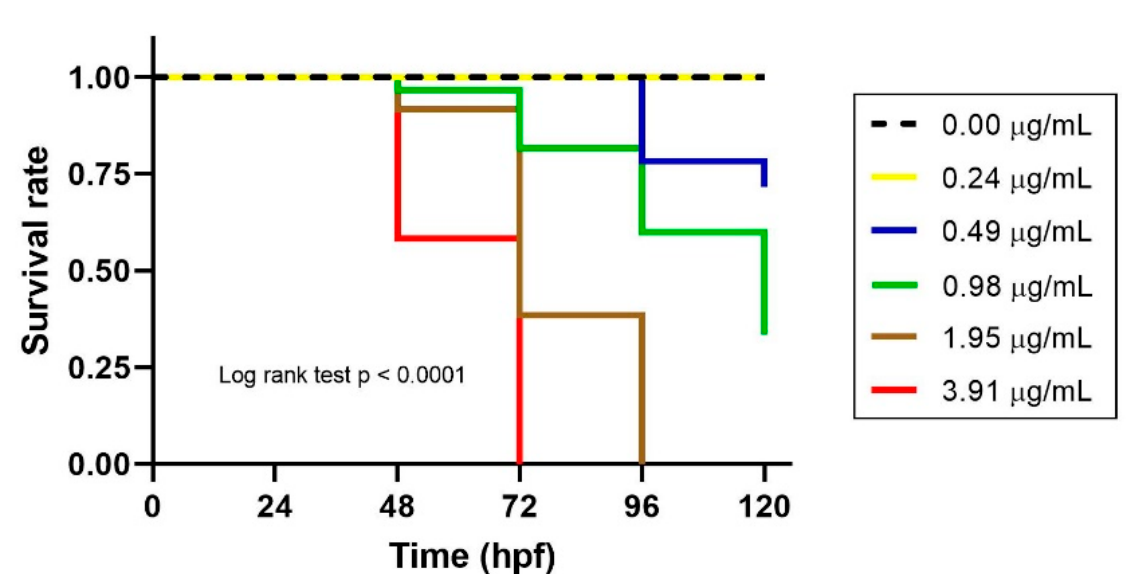
Figure 3. The embryotoxicity of different concentrations of ZO essential oil in the time–kill analysis of embryonic zebrafish. Zebrafish embryos were treated with 0.1% DMSO (control), and 0.24, 0.49, 0.98, 1.95 and 3.91 µg/mL of ZO essential oil. The Kaplan–Meier curve shows the average survival rate in six different groups in the three independent experiments ( n = 60 embryos/group). The log-rank test was used for statistical analysis ( p < 0.0001).